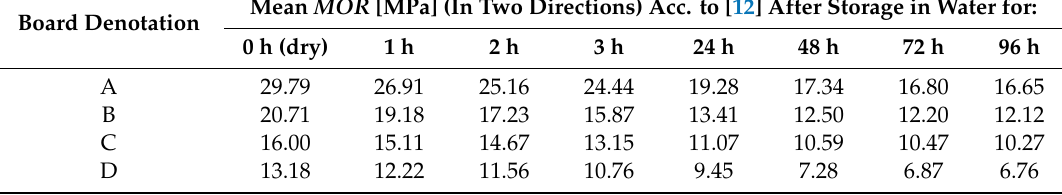
Table 5. Bending test results for boards.